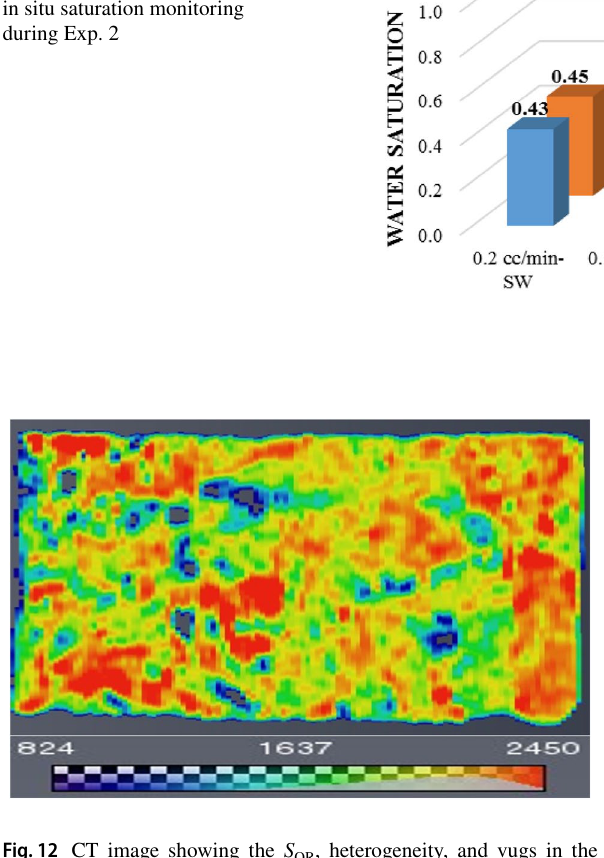
Fig. 11 Comparison between volumetric production data and in situ saturation monitoring during Exp. 2